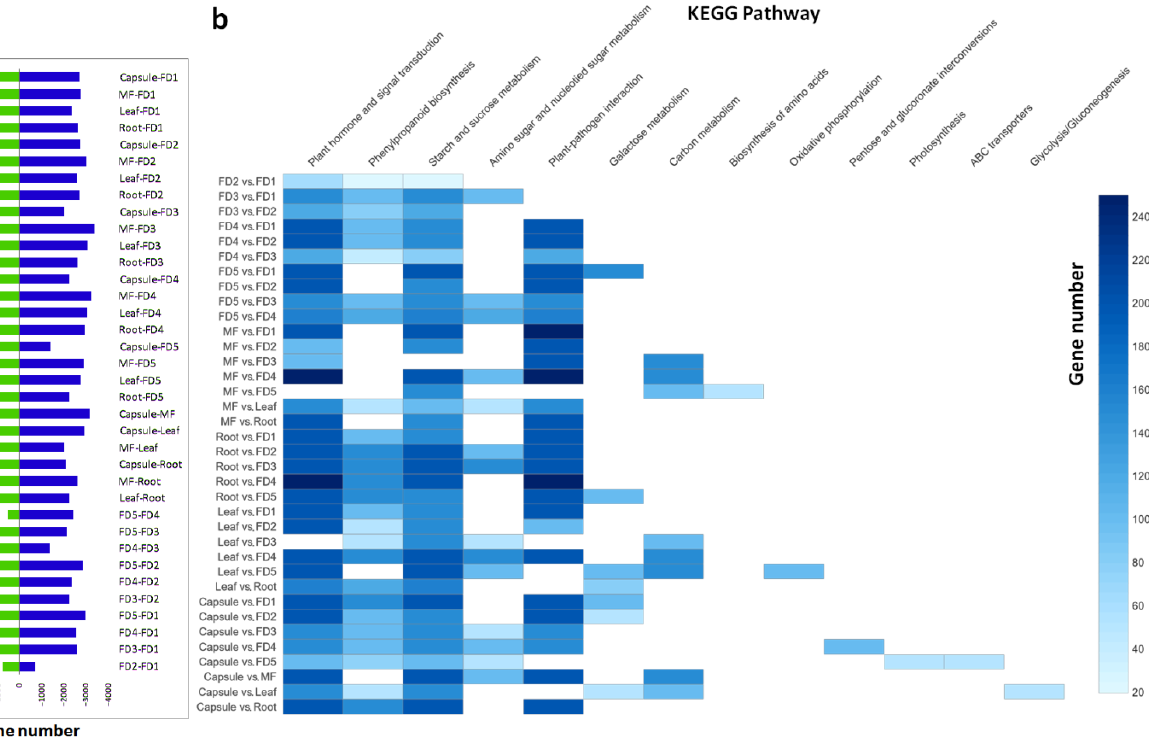
Figure 2. Comparison of up- and down-regulated DEGs among 36 pairs ( a ) and the abundance of highly enriched KEGG pathways ( b ).